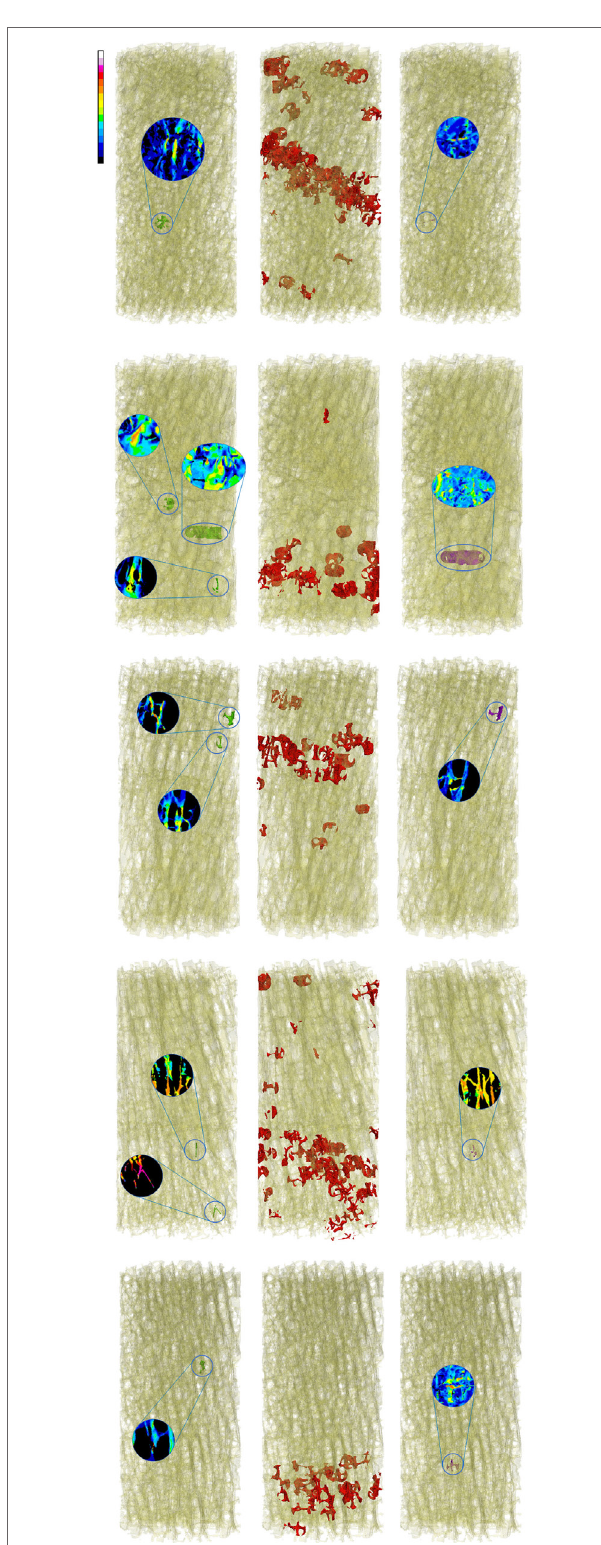
FigUre 2 | Zones of maximum compression (left) and maximum tension (right), are reported in comparison to the fracture zone (center) for the five low fracture volume specimens.